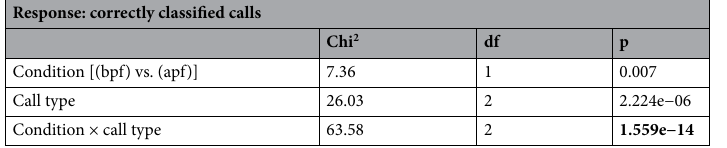
Table 3. The analysis of deviance table (Type II) for the binomial GLMM shows that the effect of pair formation on the correct assignment of calls to individuals, was call type specific. Significant (highest-order) effects are indicated with p-values in bold. pseudo-R 2 = 0.25, N observations = 106 on N Individuals = 20,in N Pairs = 10; N Call types = 3.